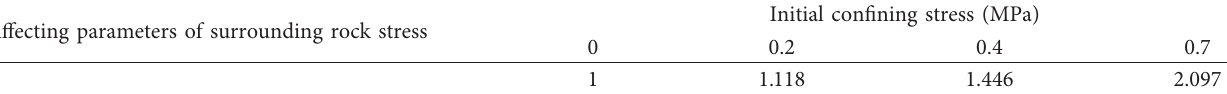
Table 3: Table of values for the influence coefficient k of surrounding rock stress under different initial confined stresses.